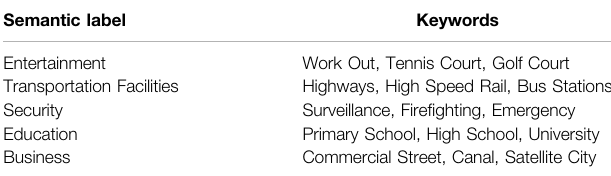
Figure 8 . For instance, the community #497 exhibits high weights